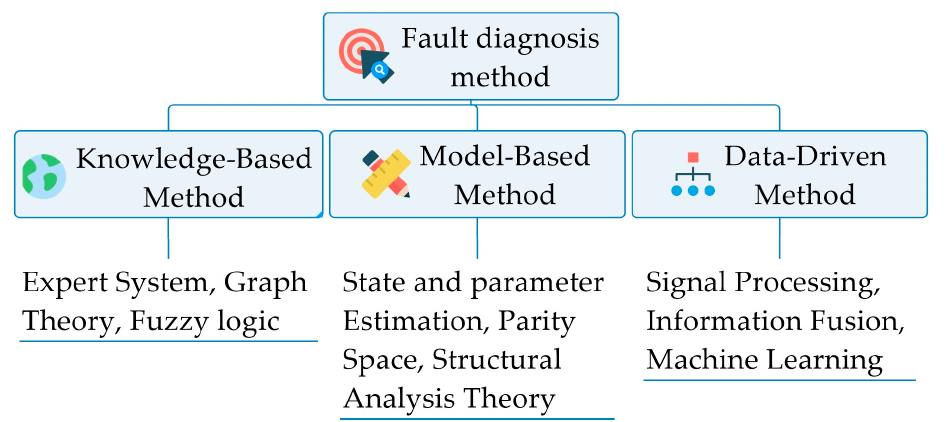
Figure 15. Fault diagnostic methods classification [149].